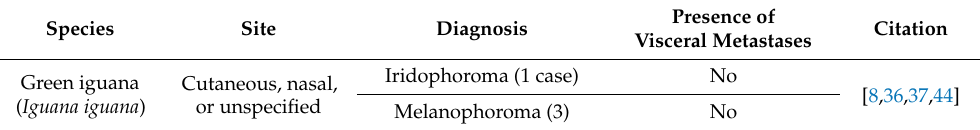
Table 2. Clinical features of chromatophoromas in the reptile family: Iguanidae .